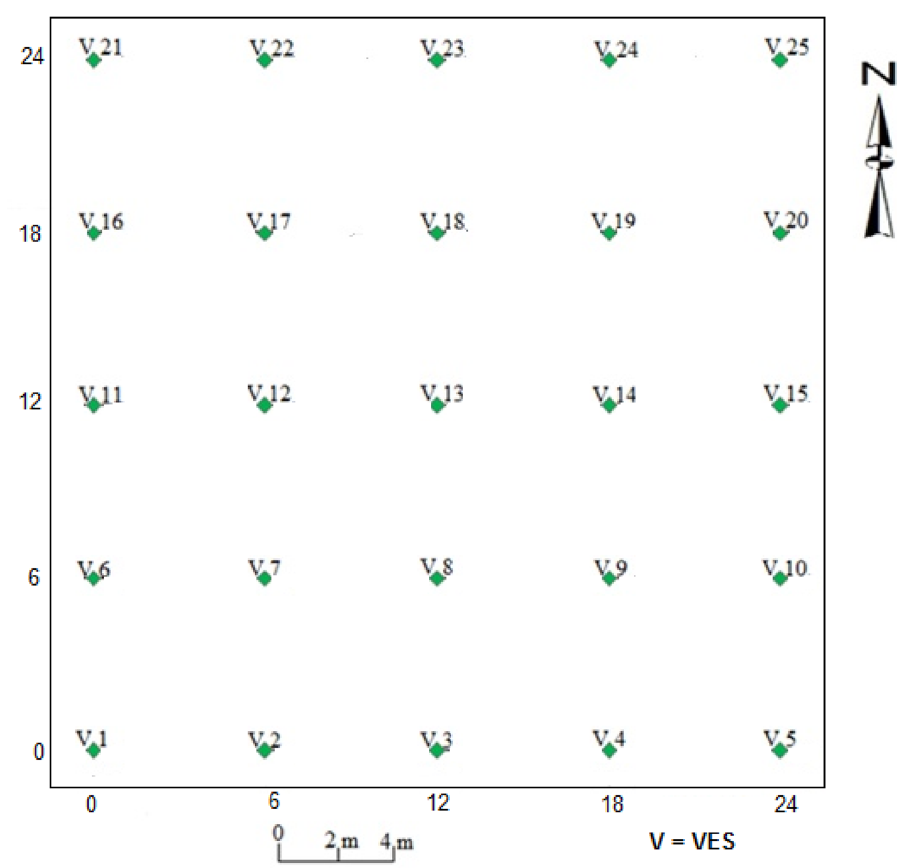
Fig. 3 Layout Showing posi- tions of vertical electrical sounding (VES)